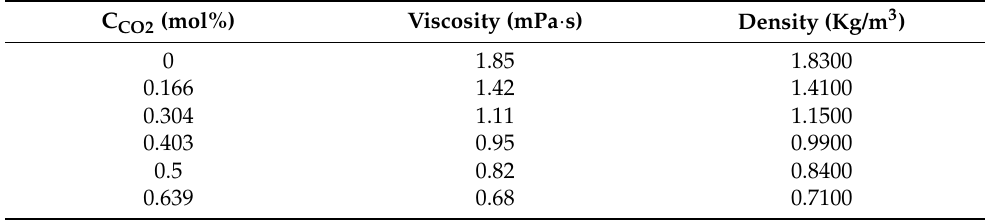
Table 3. Basic parameters of the typical numerical simulation model.